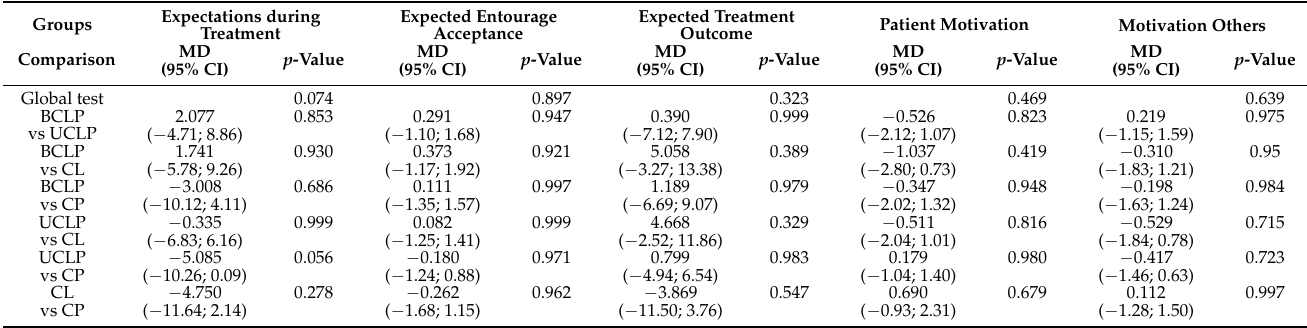
Table 7. Expectations and